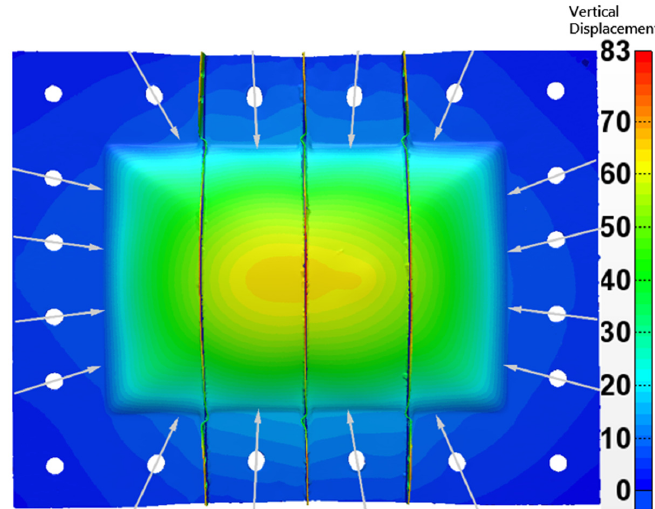
Figure 16. Bolt extension and direction in Test No. 1.